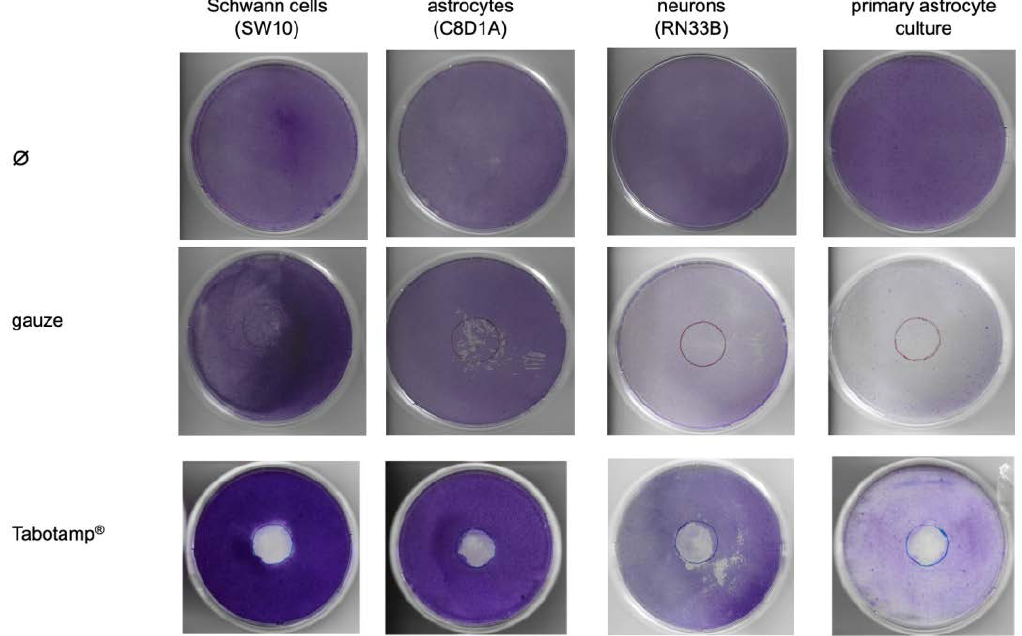
Figure 4. Impact of materials and cell type on cell adherence/ detachment. The cells were cultivated in 10 cm diameter dishes to complete confluence and then incubated with Tabotamp ® or